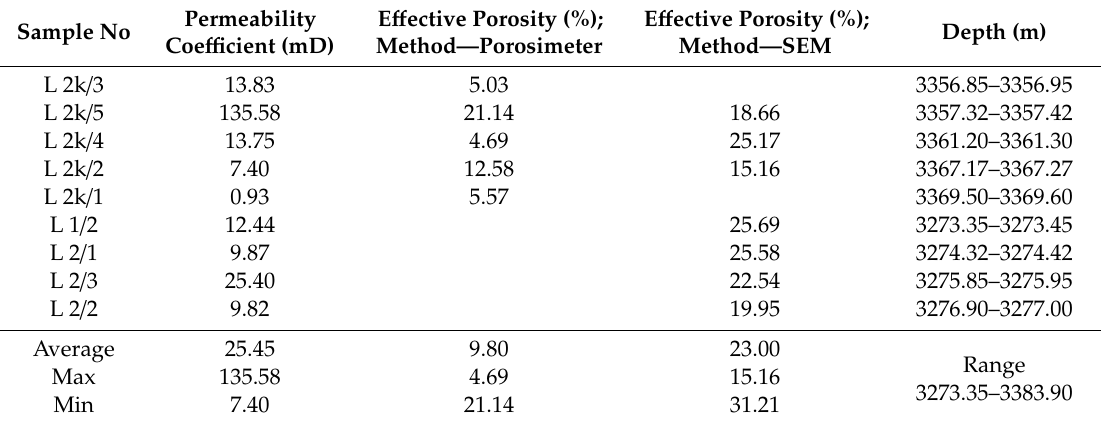
Table 4. Permeability and porosity values of the Main Dolomite—Lubiat ó w